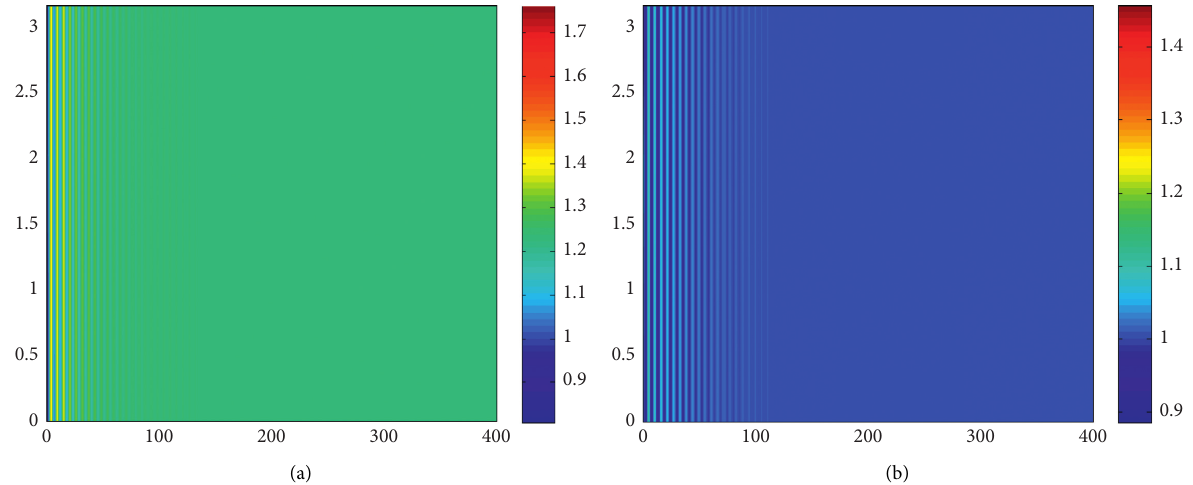
Figure 2: The spatial pattern of the system with Neumann boundary for τ ( t,x ) . (b) Spatial pattern of y of y 1